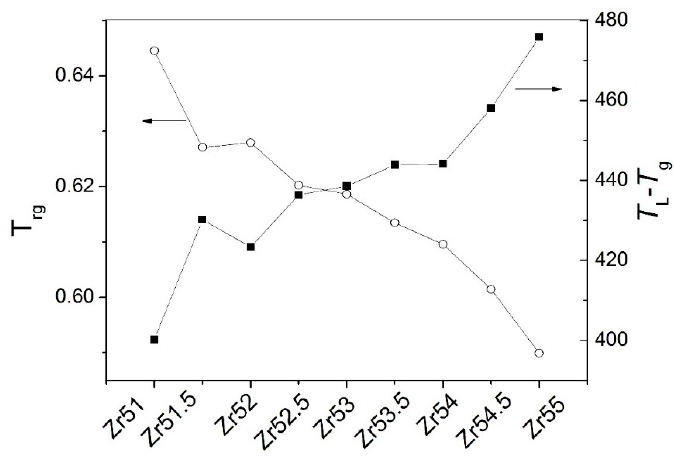
Figure 13. Dependences of the T rg and T L - T g on the Zr content.